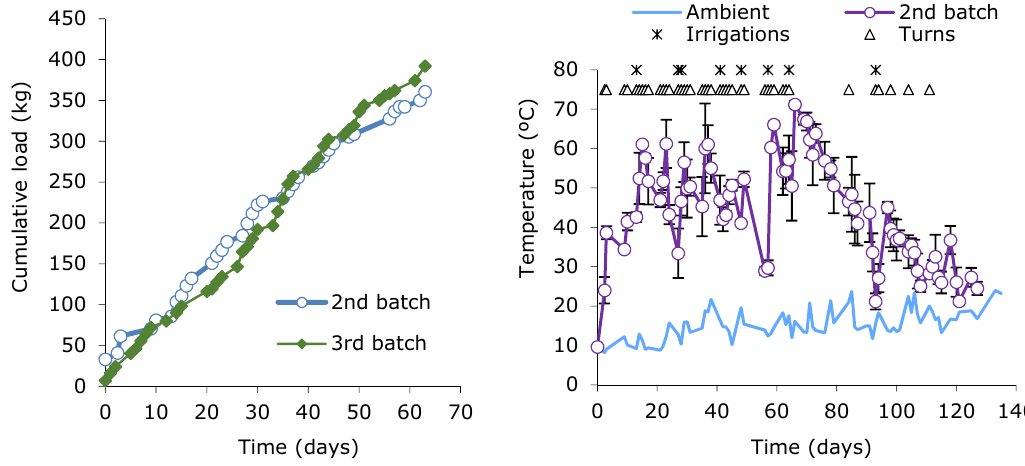
Figure 2. Cumulative loads (BWUC + GrW) on the left and temperature evolution on the right in the Philology Faculty composters. Data corresponds to the second and third batches (loads) and second batch (temperature).